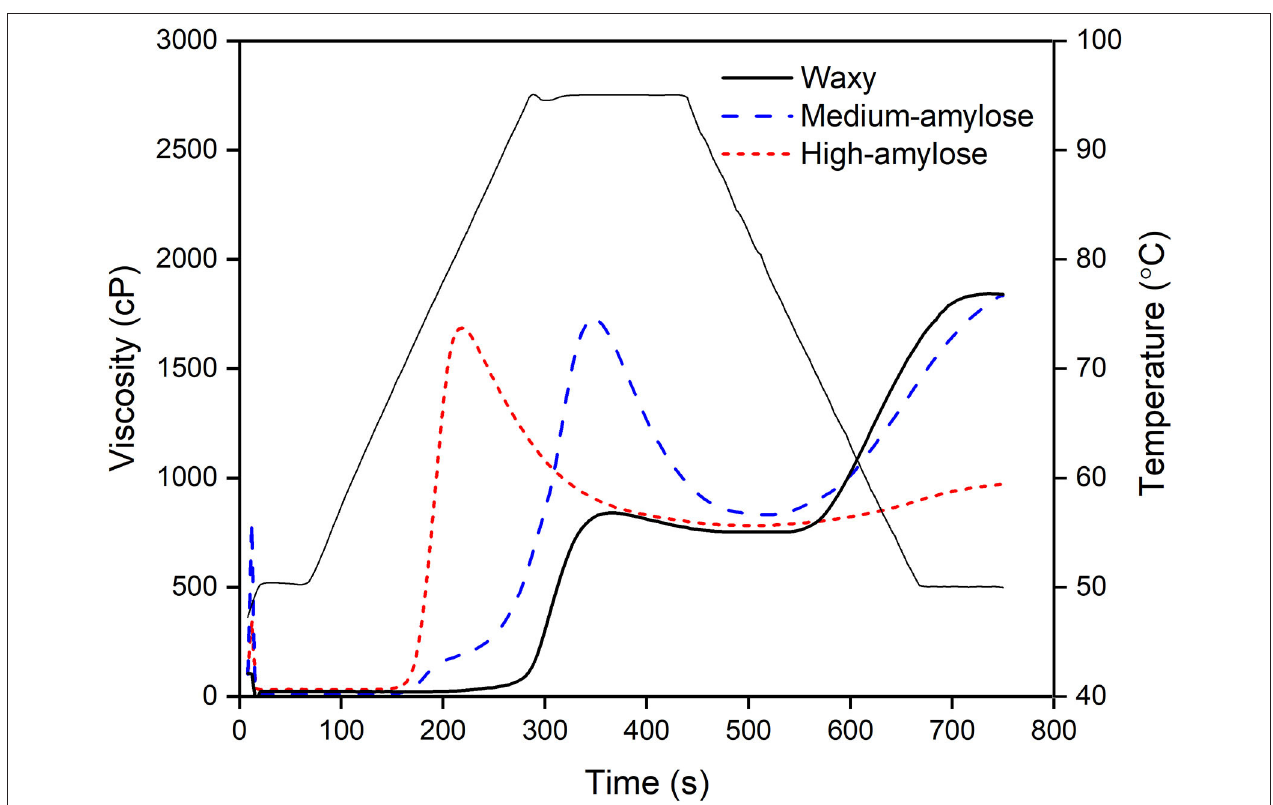
FIGURE 1 | Pasting curves of waxy, medium-amylose, high-amylose black rice.